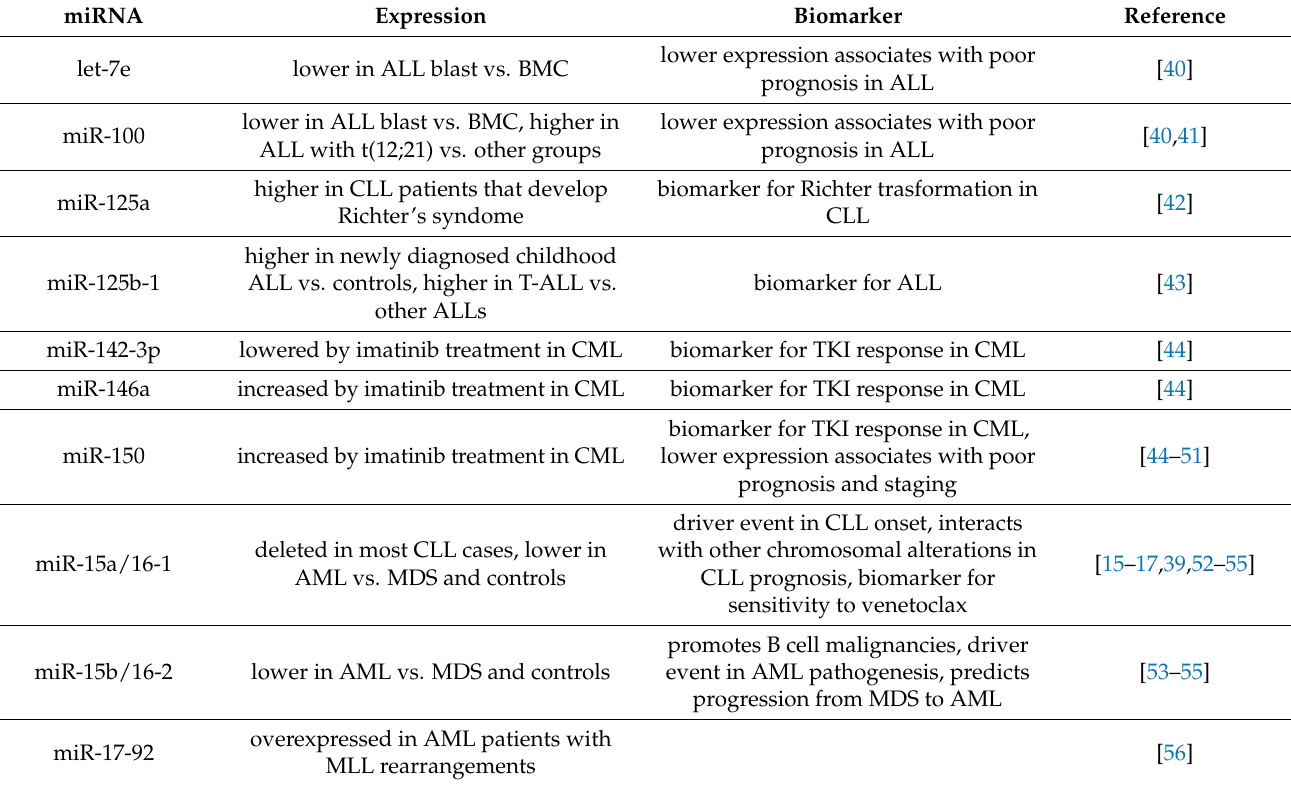
Table 1. Differentially expressed small non-coding RNAs in chronic and acute human